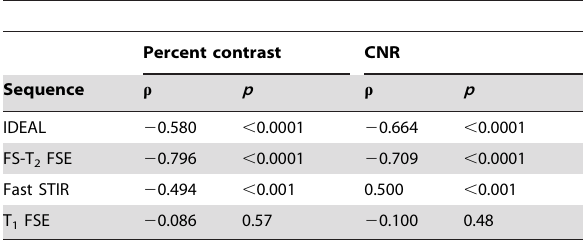
Table 2. Results of Spearman rank correlation for percent contrast and CNR with BMPC% among the four different sequences in multiple myeloma